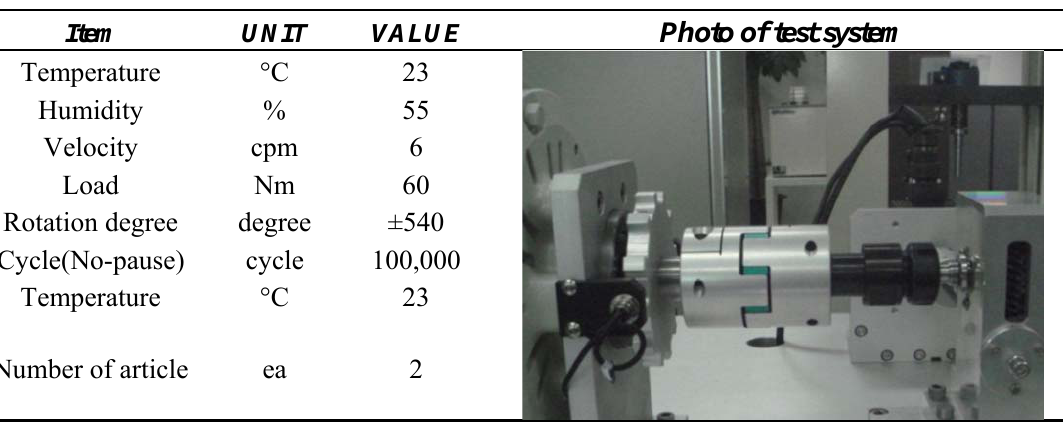
Table 9. Durability test conditions of worm wheel.